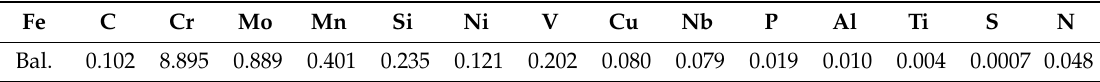
Table 1. Composition of the steel T91 as provided by the producer in wt.